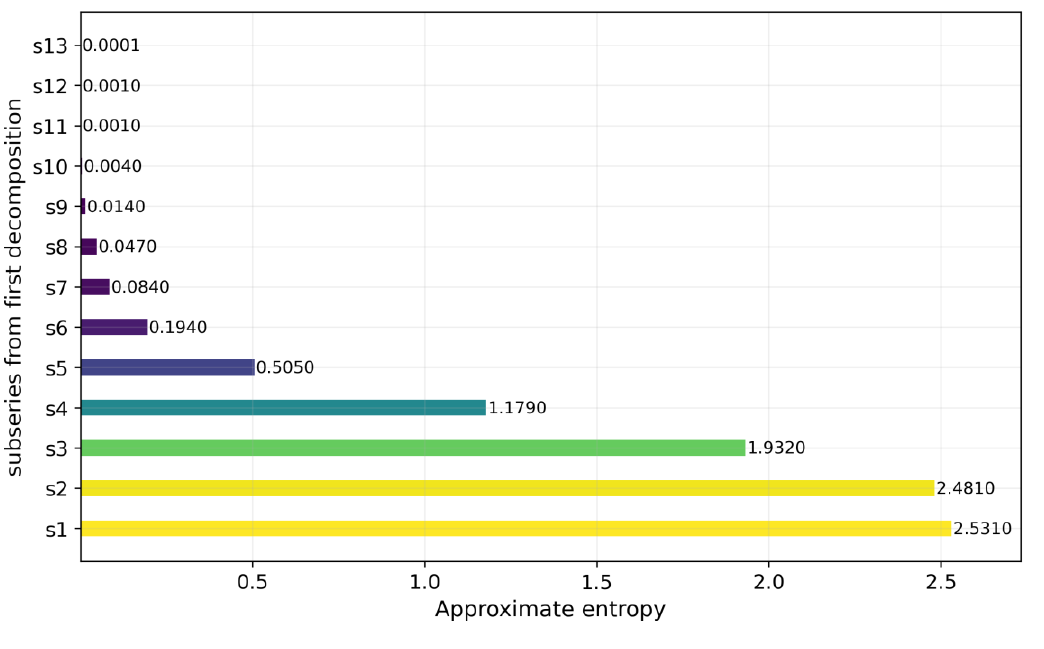
Figure 3. AE calculation.